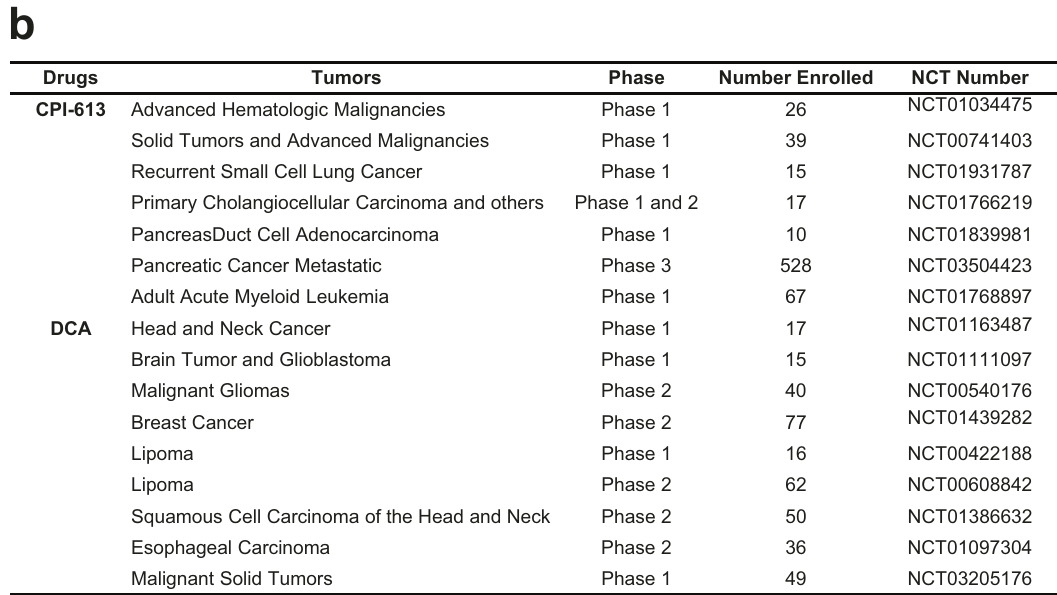
Fig. 1 Drugs targeting PDH in clinical trials. a In the absence of lactate, pyruvate may step into PC-mediated metabolic process with accumulated oxaloacetate, which can be converted into PDH pathway by additional lactate from TME. These metabolic outcomes from both enzyme catalytic pathways participate TCA cycles to support energy supplement. DCA and CPI-613, as small molecule targeted drugs, indirectly present positive and negative effects on PDH, respectively. b Several completed clinical trials within pan cancers are listed